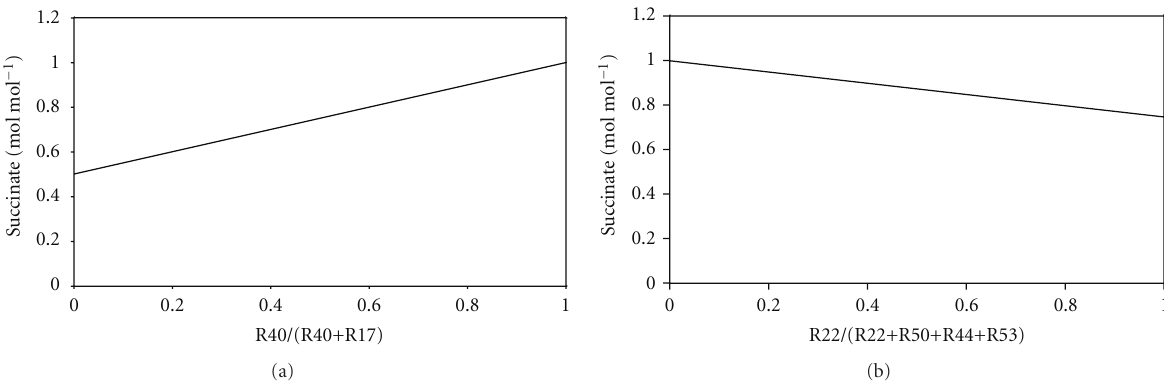
Figure 7: Sensitivity of succinate yield to the relative fluxes at the (a) PEP node and (b) AcCoA node under aerobic conditions. The PEP node involves the catabolic reactions of R40 and R17 which are catalyzed by PEP carboxylase and pyruvate kinase, respectively. The AcCoA node involves the catabolic reactions of R22, R50, R44, and R53 which are catalyzed by citrate synthase, aldehyde dehydrogenase, malate synthase, and phosphate acetyltransferase, respectively.